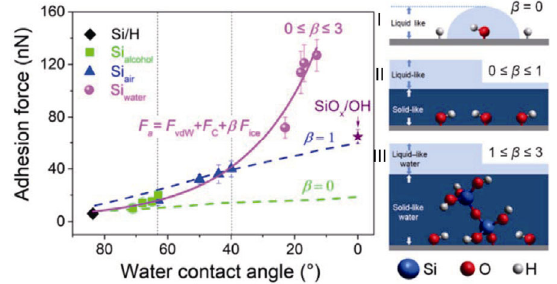
Fig. 6 Adhesion force vs. water contact angle of Si 3 N 4 / silicon pairs simulated with contributions of van der Waals force ( F vdW ), capillary force of liquid meniscus ( F c ), and force necessary to break strongly hydrogen-bonded water network ( F ice ). Bottom green and middle blue dashed lines represent F vdW + F c and F vdW + F c + F ice , respectively. The rhodopsin solid line represents F vdW + F c + β F ice , where 0 ≤ β ≤ 3 depending on water adsorption is related to chemistry and structure of oxidized surface layer, as shown in insets on right. Reproduced with permission from Ref. [85], © American Chemical Society